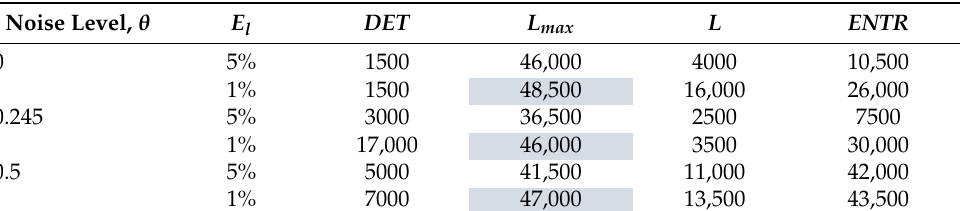
Table 2. Time series length corresponding to relative errors equal to 5% and 1% in the estimates of determinism, maximal diagonal line length, average diagonal line length, and entropy for three different noise levels of the Rössler time series. The values highlighted indicate the lower limit of the length of the time series required for accurately estimating the four features.